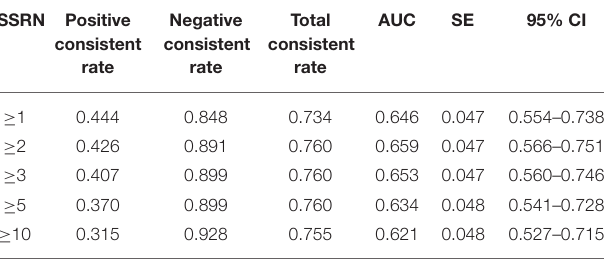
TABLE 2 | Comparison of the diagnostic efficacy of five positive mNGS criteria for viral encephalitis and/or meningitis (Definite, n = 54). SSRN Positive